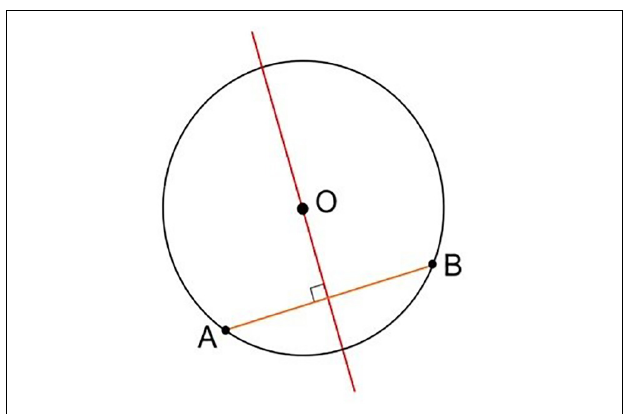
FIGURE 11 | Geometric representation of the perpendicularity obtained, considering the plane as tangent to the spherical surface at the entry point.